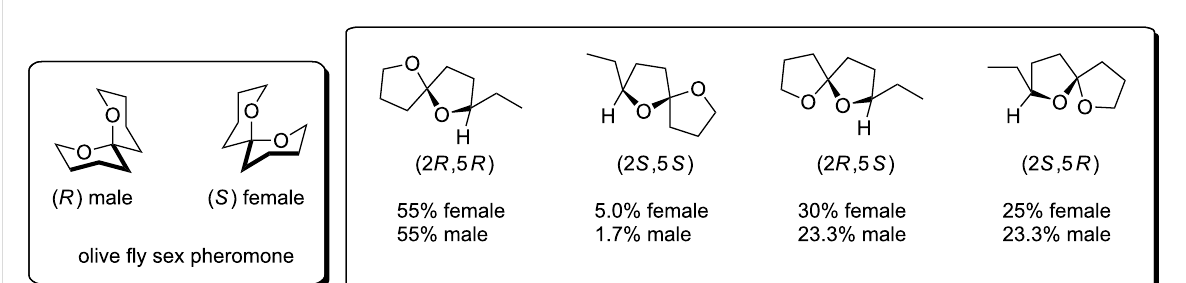
Figure 1: Pheromone spiroketals.